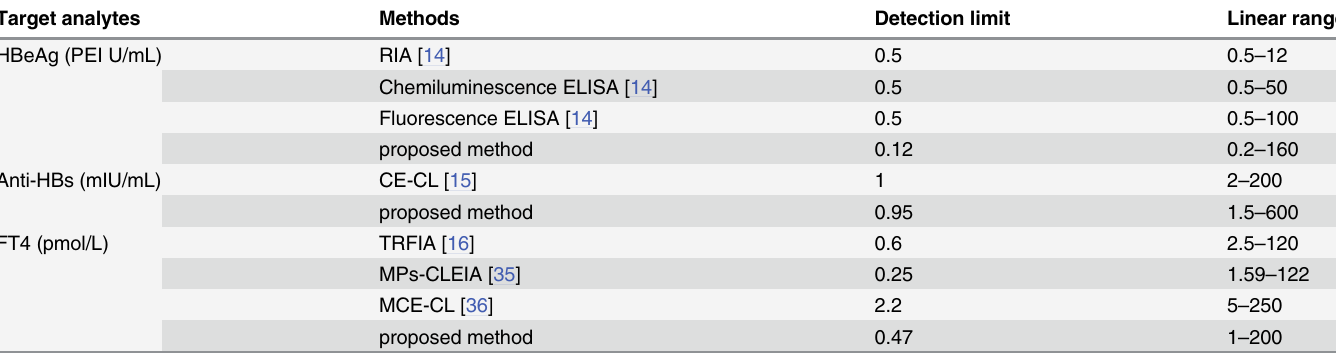
Table 1. Comparison of sensitivity and linear range for the determination of HBeAg, Anti-HBs and FT4 by previously reported